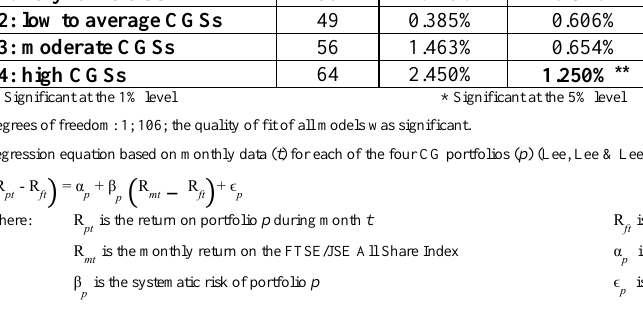
Table 6: CAPM estimation results CG portfolio